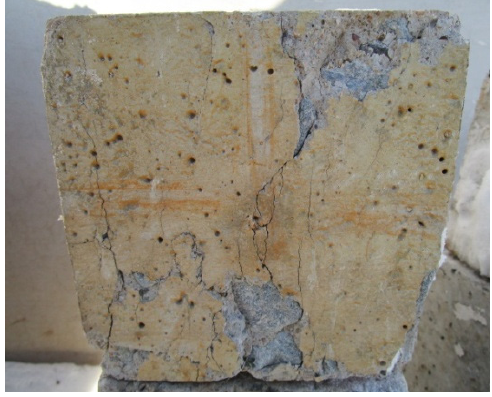
Figure 7. Sulfate corrosion for crumb rubber concrete.